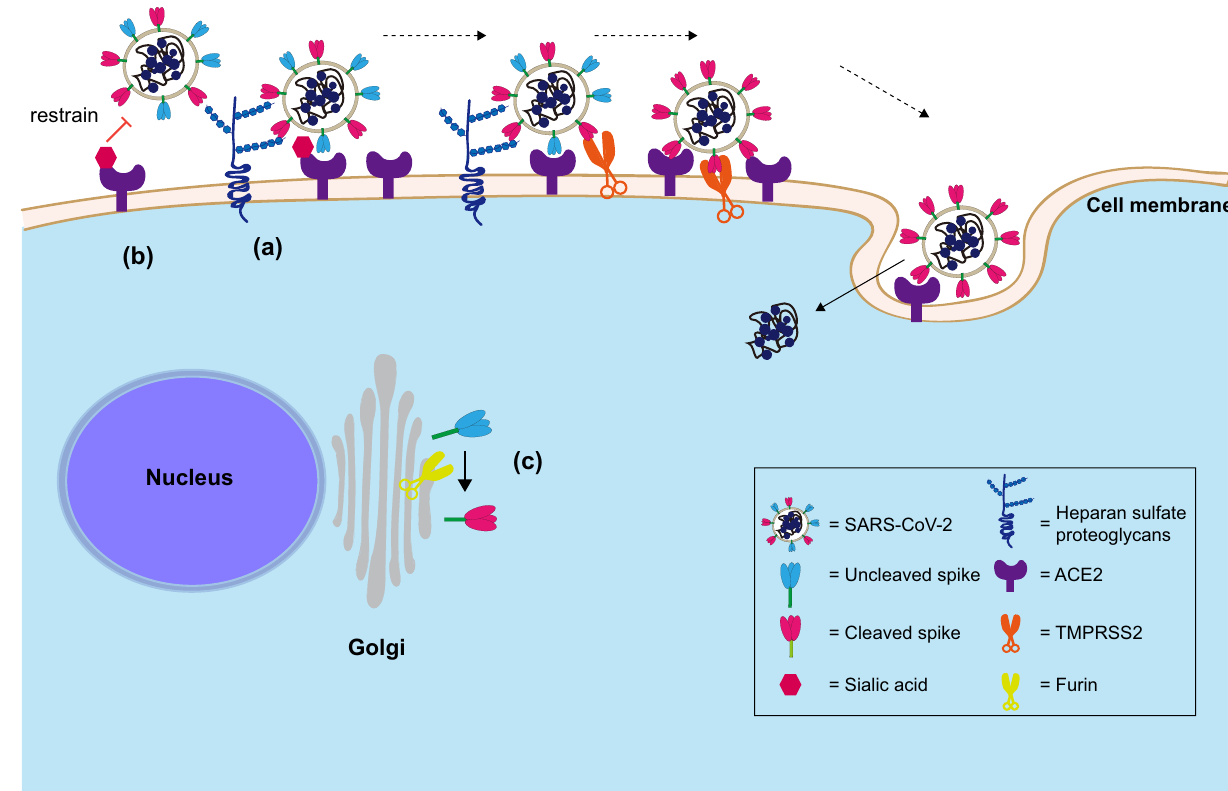
Fig. 7 Schematic of the host and viral determinants for SARS-CoV-2 infection of the human lung as revealed in this study. a SARS-CoV-2 can utilize cell surface heparan sulfate proteoglycan as an attachment receptor. b Sialic acids present on ACE2 precluded perfect spike/ACE2-interaction but SARS-CoV- 2 is affected to a lesser extent by the sialic acid-mediated restriction in lung cells in comparison with SARS-CoV. c Furin cleavage of SARS-CoV-2 spike is essential for ef fi cient SARS-CoV-2 replication in the human lungs, which is potentially due to the relatively low level of TMPRSS2 expression in the